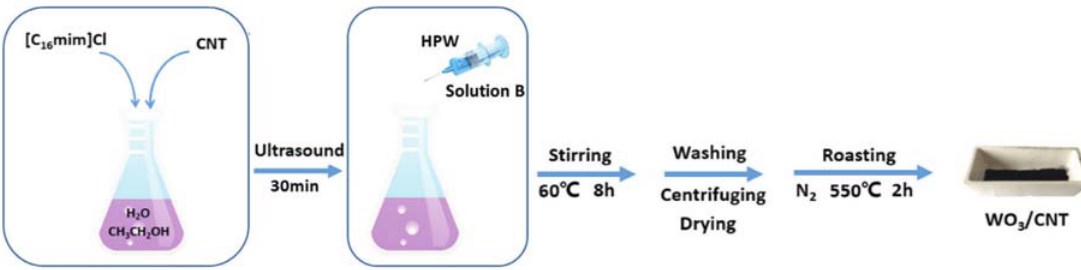
Figure 14. Schematic description of WO 3 / CNT catalyst preparation. Reproduced with permission [132]. Copyright 2019, Wiley and Society of Chemical Industry.